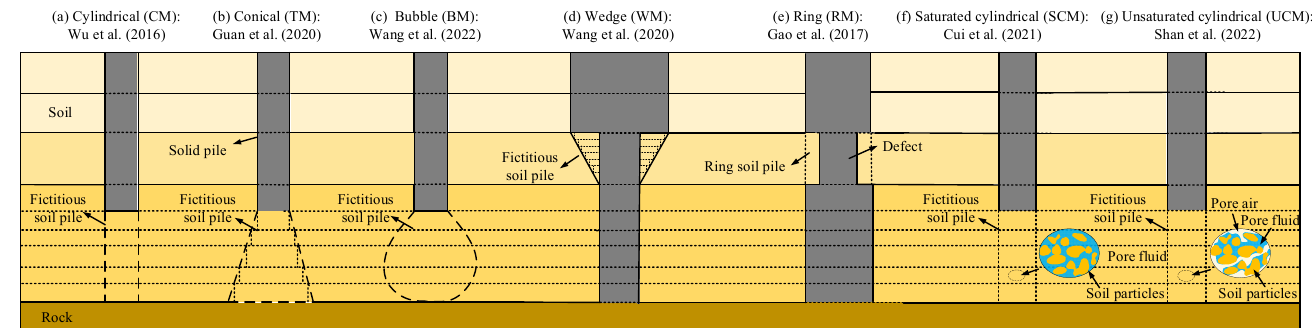
Figure 7. Category of the fictitious soil pile model: ( a ) Ref. [56]; ( b ) Ref. [63]; ( c ) Ref. [64]; ( d ) Ref.